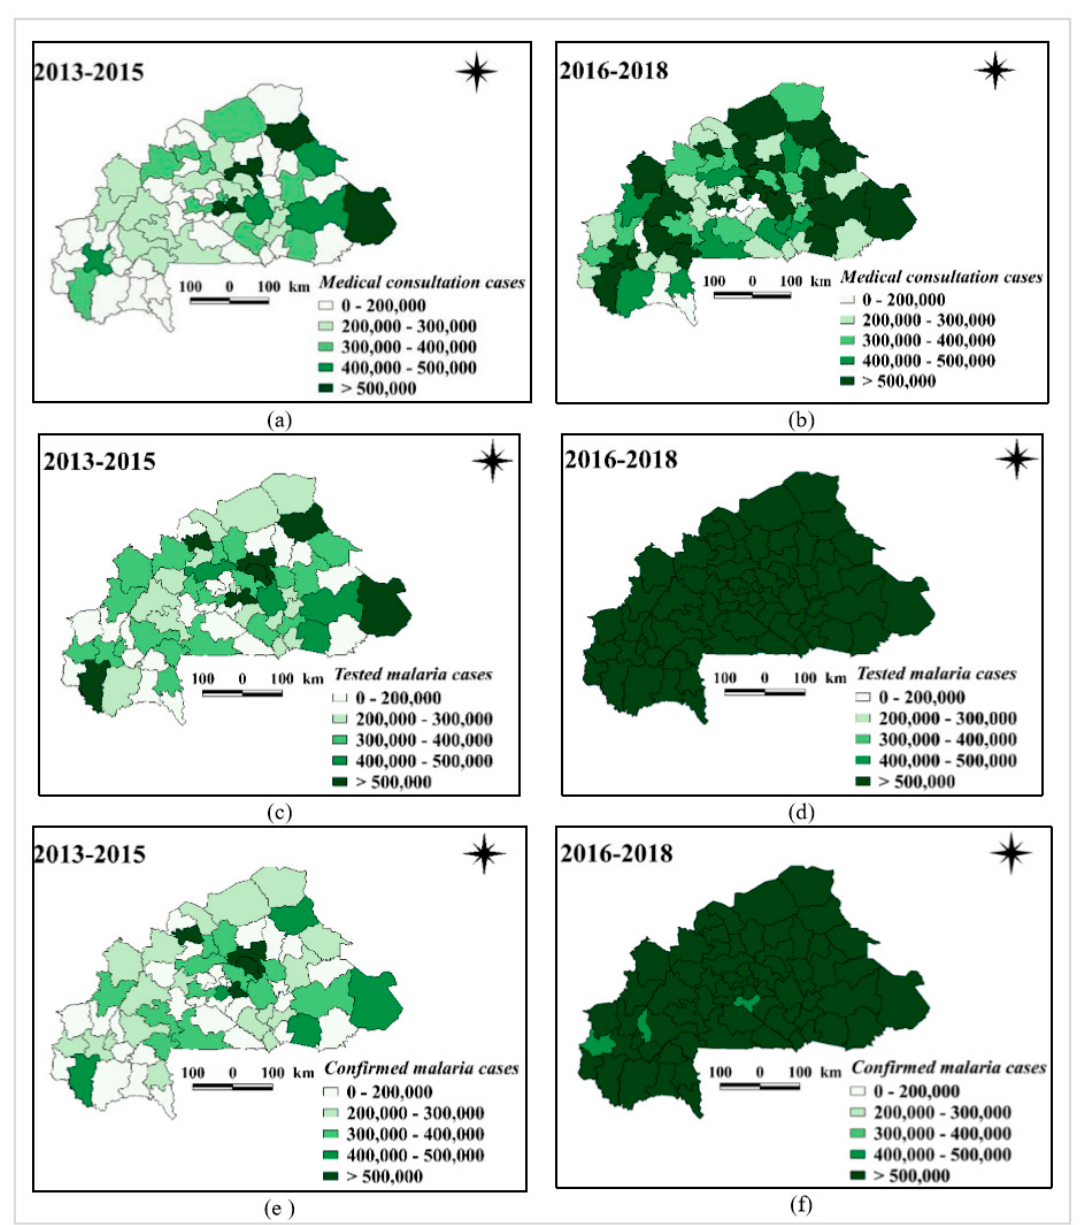
Figure 2. Spatio-temporal distribution: ( a ) number of consultations per district 2013–2015; ( b )